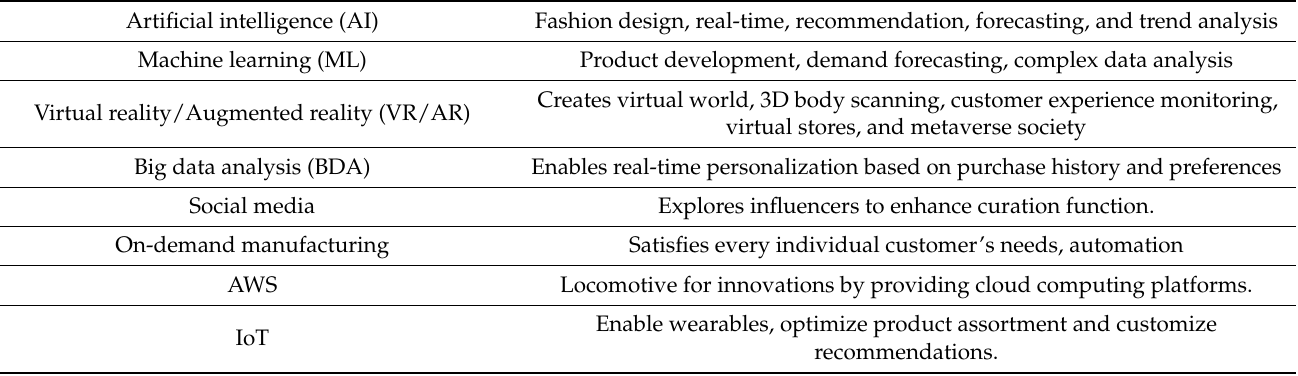
Table 2. Digital innovations supporting the fashion industry toward advanced digital fashions. Artificial intelligence (AI) Fashion design, real-time, recommendation, forecasting, and trend analysis Product development, demand forecasting, complex data